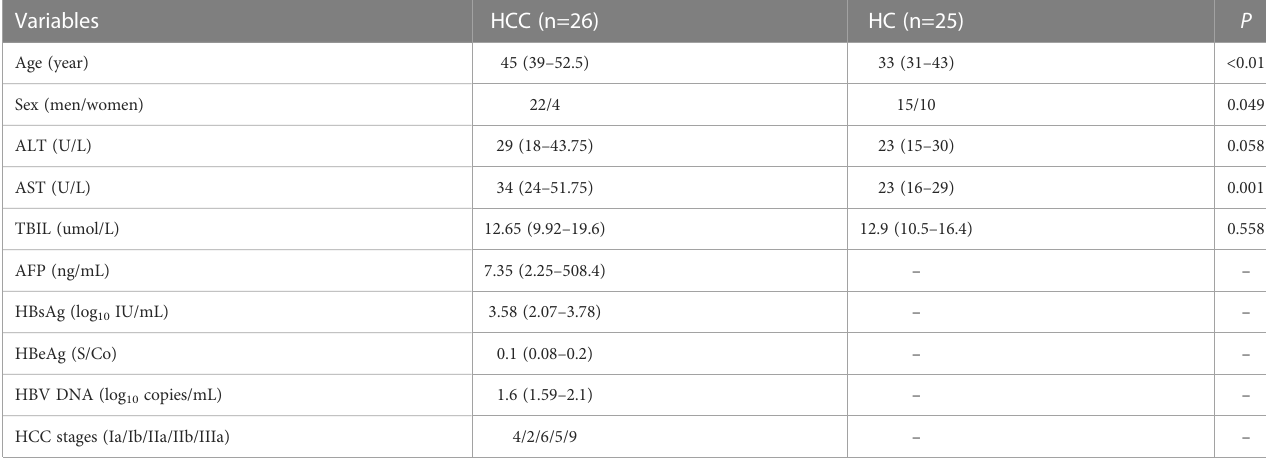
TABLE 1 Clinical characteristics of the enrolled patients at